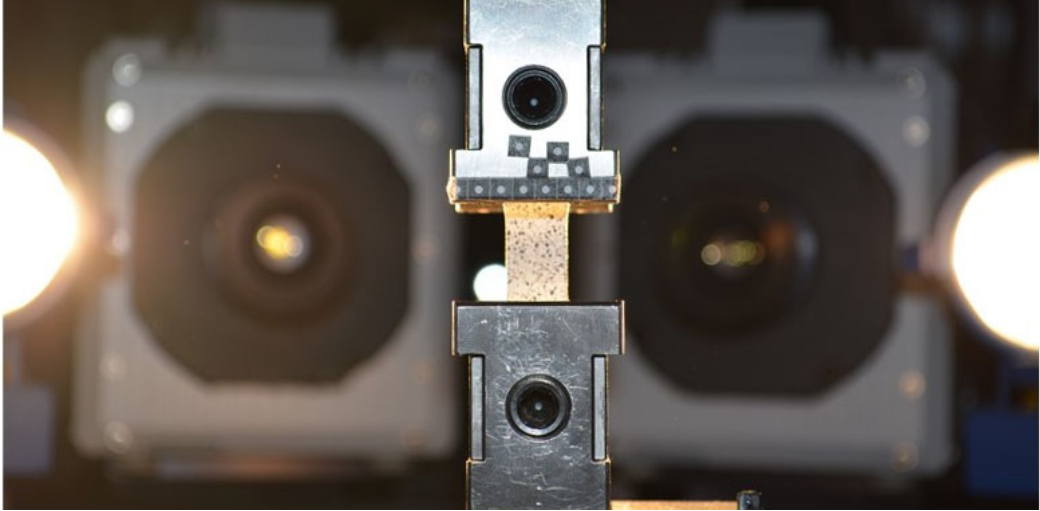
Figure 6. Camera setup with the GOM ARAMIS 3D HHS in the background, during the tensile test.